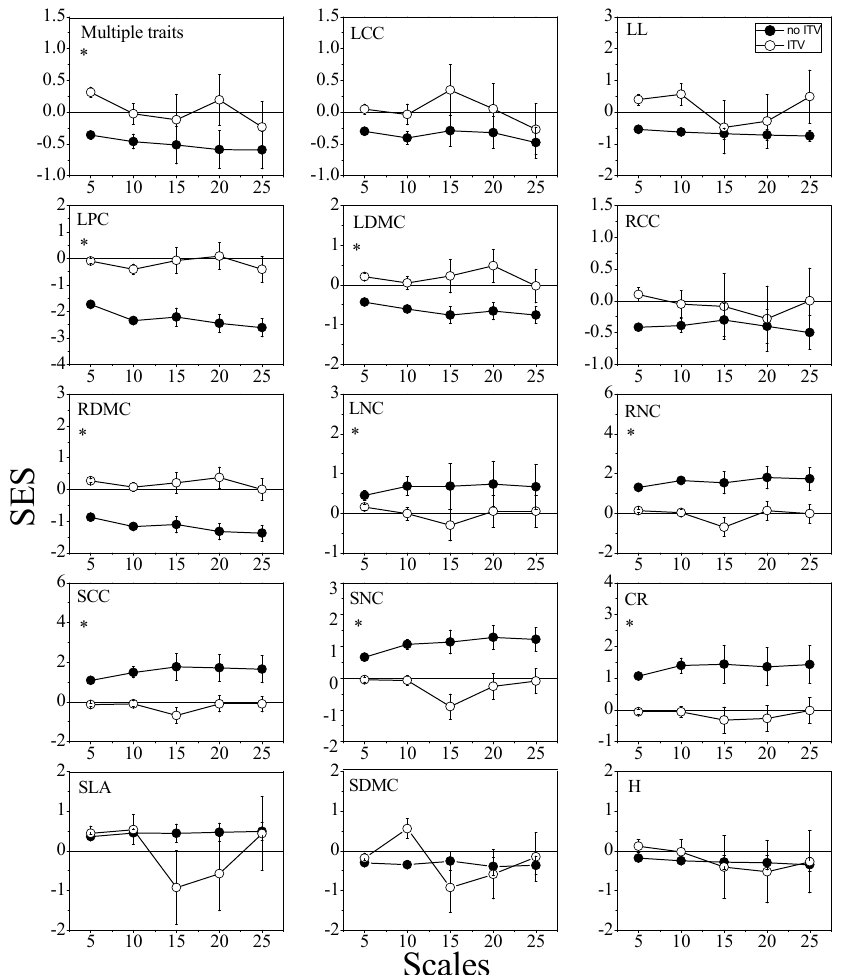
Figure 4. Influence of spatial scales on the standard e ff ect size of functional diversity (SES, mean ± SE). SES represents the deviation of functional diversities of a plot at a given spatial scale from its null distributions. There are five spatial settings: 5 m × 5 m, 10 m × 10 m, 15 m × 15 m, 20 m × 20 m, 25 m × 25 m. The SES of multiple traits for di ff erent spatial scales is shown in the top left panel. The SESs of single traits for di ff erent spatial scales are shown in their respective panels (including leaf carbon content (LCC), leaf dry matter content (LDMC), leaf phosphorus content (LPC), leaf nitrogen content (LNC), stem dry matter content (SDMC), stem carbon content (SCC), stem carbon content (SNC), root carbon content (RCC), root nitrogen content (RNC), root dry matter content (RDMC), canopy range (CR), leaf length (LL), specific leaf area (SLA), and height (H)). Hollow black point: including ITV; solid black point: not including ITV, * means p < 0.05.